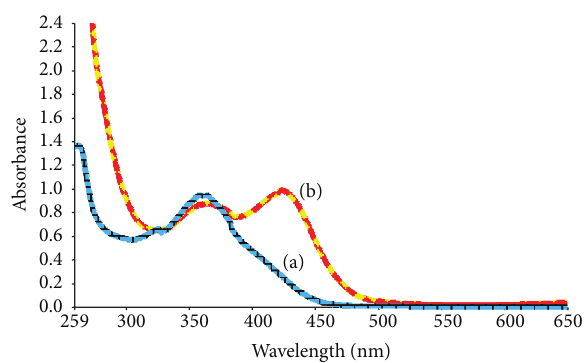
Figure 2: Relative UV-Vis spectra of morin and Cr(III) complex in DMSO. (a) UV-Vis spectrum of morin; (b) UV-Vis spectrum of morin-Cr(III) complex.